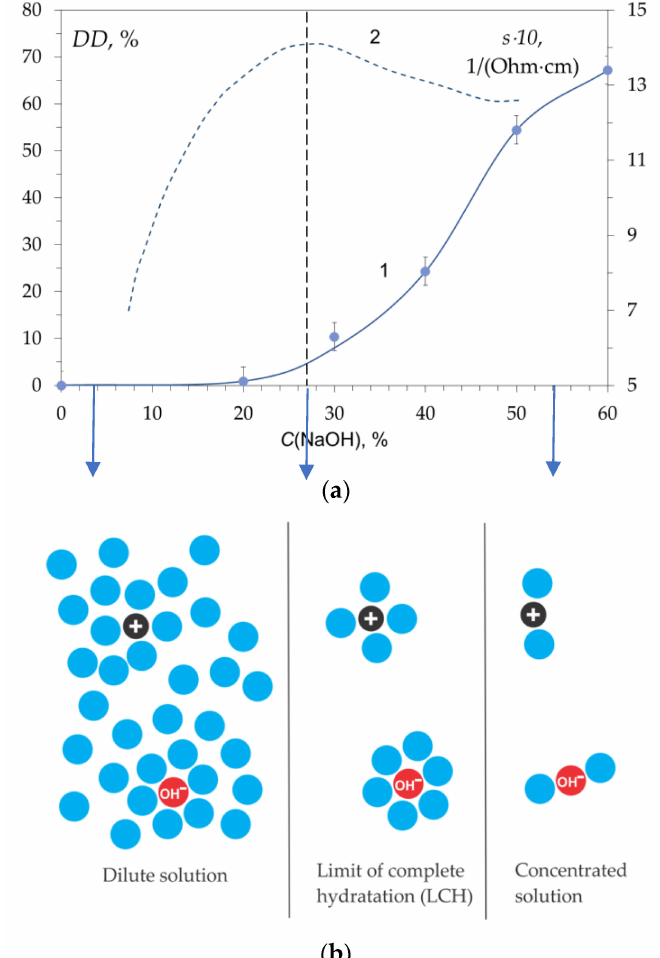
Figure 11. ( a ) Deacetylation degree, DD, (1) and electrical conductivity of the NaOH solution, s, (2) as a function of alkali concentration at T = 100 ◦ C. ( b ) Scheme describing the formation of existence of a limit of complete hydration (LCH). Original